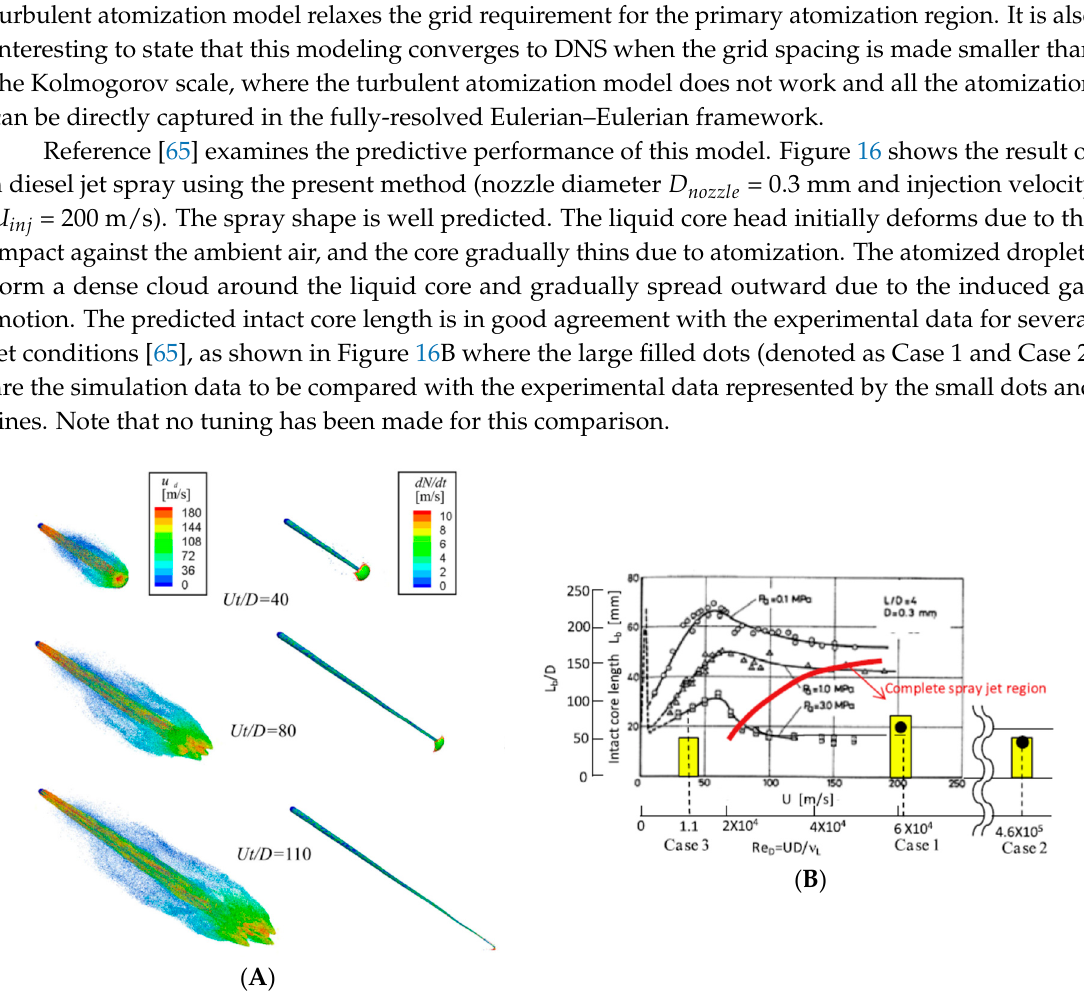
Figure 16. Result of spray simulation using the subgrid-scale (SGS) turbulent atomization model [65]. ( A ) Evolution of the entire spray and the liquid core, where the droplet color indicates the axial velocity and the core color indicates the surface regression velocity due to atomization dN / dt ; ( B ) Comparison of the intact core length with experimental data [37]. The large filled dots (Case 1 and Case 2) are the simulation data to be compared with the experimental data represented by the small dots and lines.